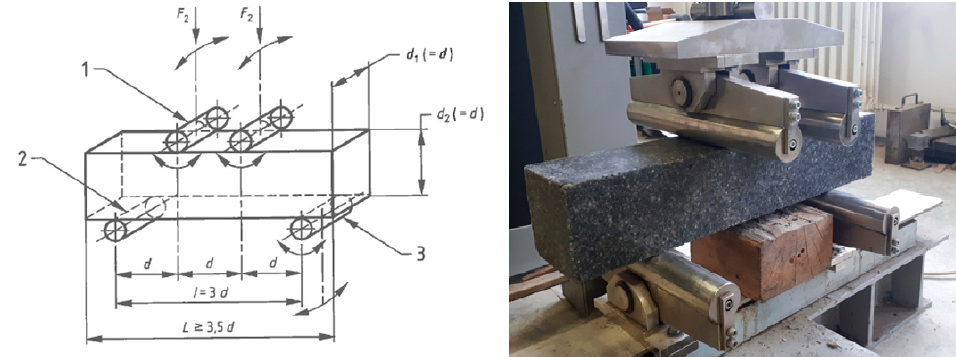
Figure 7. Test sample mounting scheme.